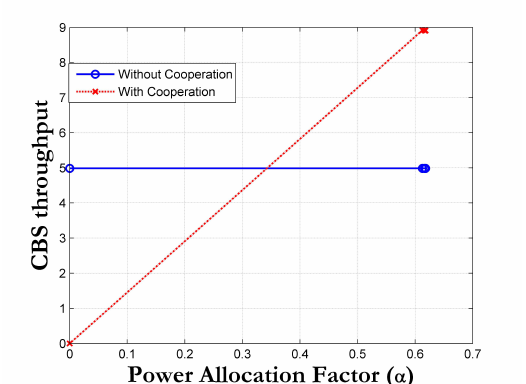
Figure 5. CBS throughput with and without cooperation.